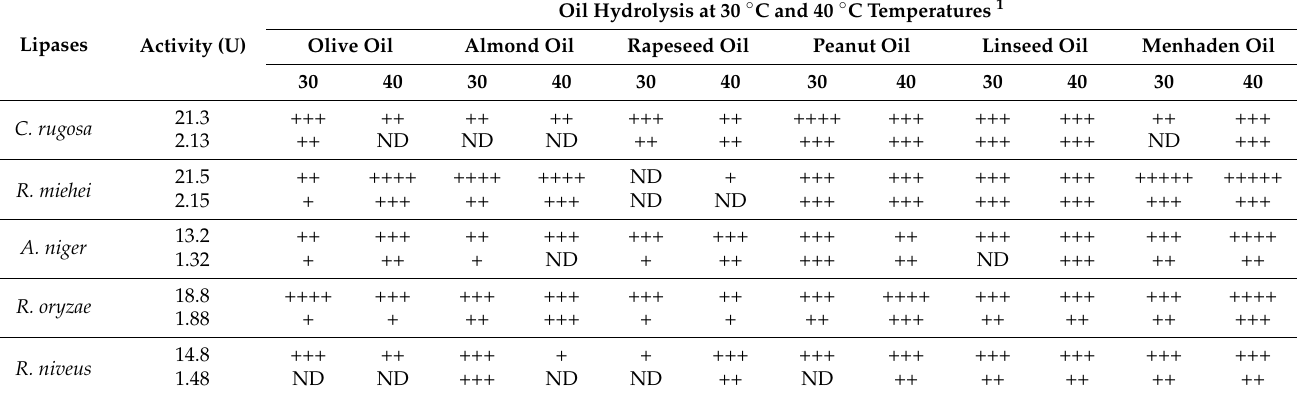
Table 1. Hydrolysis of natural oils by commercial lipases on chromogenic plates incubated at 30 ◦ C and 40 ◦ C temperatures. The width of the yellow color zone is proportional with the level of hydrolysis. The data presented show the best degradation capacity of each enzyme for a given